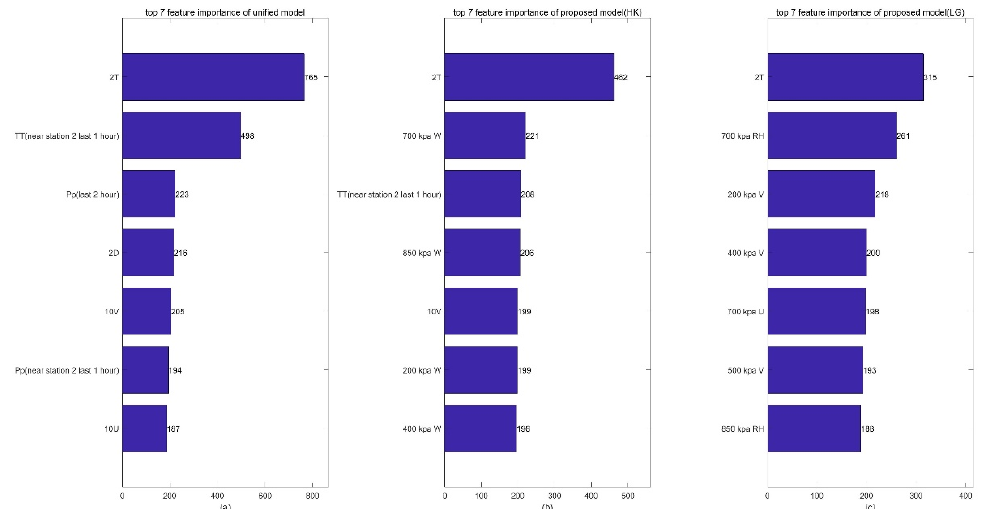
Figure 11. Top 7 features in terms of their importance to the temperature prediction calculated by the proposed spatial lightGBM and the unified spatial lightGBM: ( a ) top 7 feature importance of unified model; ( b ) top 7 feature importance of proposed model in Haikou; ( c ) top 7 feature importance of proposed model in Lingao.